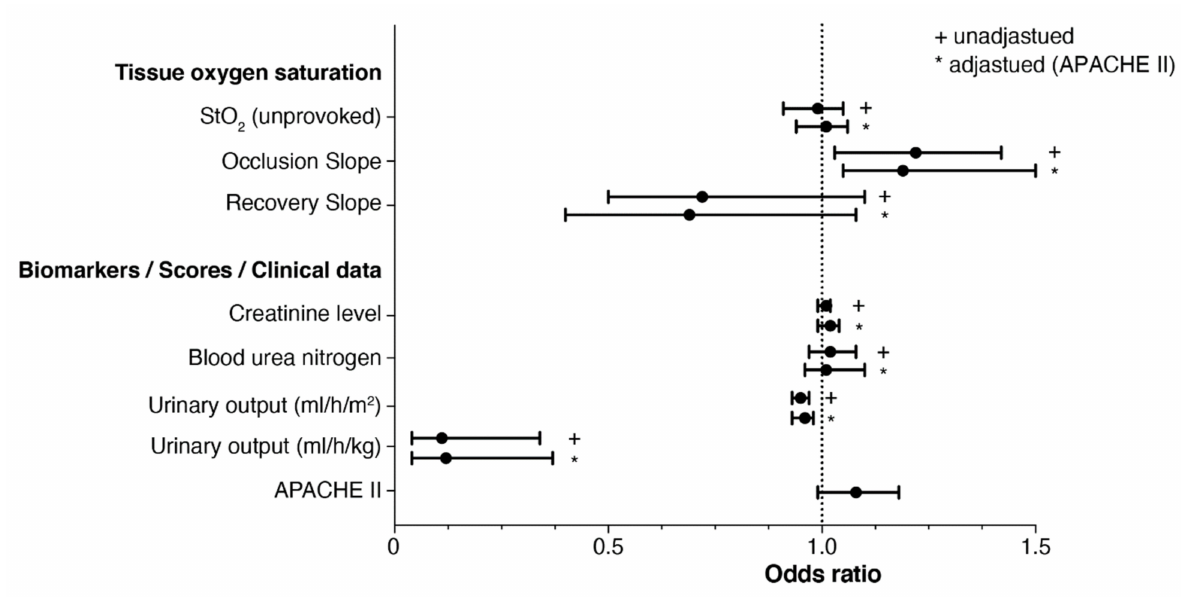
Figure 4. Forrest plot showing the unadjusted and adjusted odds ratios regarding the prediction of renal replacement therapy. APACHE II, acute physiology and chronic health